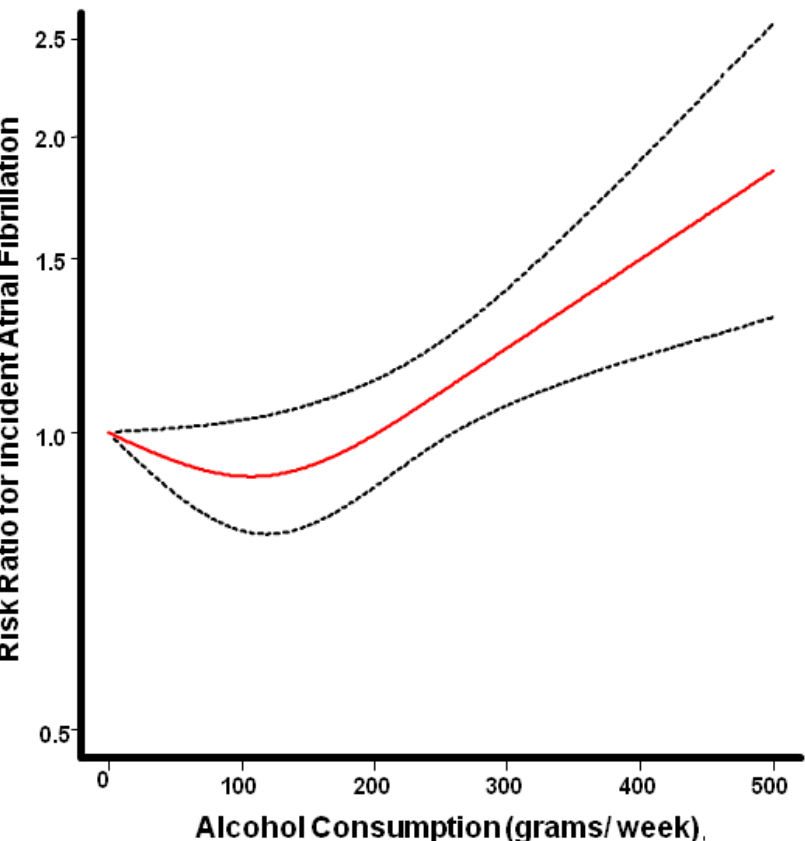
Figure 5. Pooled dose response relationship between weekly alcohol consumption and risk for incident atrial fibrillation seems to follow a J shaped pattern. Abstinence served as the reference category. The red line depicts the estimated risk ratio, while the dotted lines represent the corresponding 95% confidence intervals.